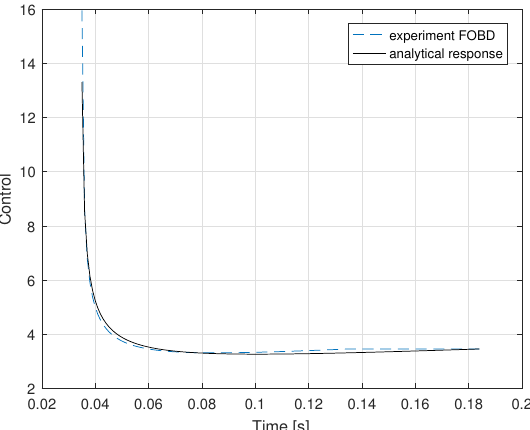
Figure 5. The step-response of FOPID using FOBD vs. the analytical response for α = 0.5, β = 0.5. IAE = 0.0151, and ISE = 0.0085.